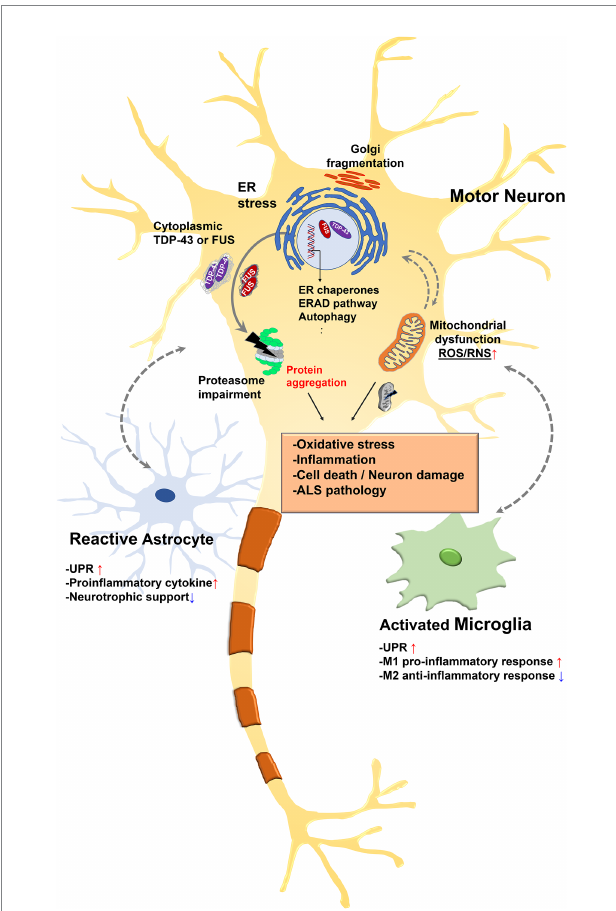
FIGURE 2 Relationship between endoplasmic reticulum (ER) stress and amyotrophic lateral sclerosis (ALS)-associated pathology. Misfolded proteins accumulate in the ER lumen and this accumulation contributes to ER stress. ER stress triggers the UPR to restore protein homeostasis. However, chronic stress leads to a cascade of intracellular death and inflammatory signal. Some nuclear ALS disease proteins such as TAR DNA-binding protein 43 (TDP-43) or fused in sarcoma (FUS) are depleted in the nucleus and accumulate in the cytoplasm in pathologic condition. Pathologic TDP-43 or FUS are existed as hyperphosphorylated and ubiquitinated form. Persistent activation of the stress response leads to ER dysfunction and ubiquitin proteasome system (UPS) impairment, leading to reactive oxygen species (ROS) and RNS release in mitochondria. This eventually leads to insoluble cytoplasmic aggregation and impairment of mitochondrial and ER function. Furthermore, UPR-related genes are upregulated in astrocytes and microglia along with inflammatory genes. Specifically, UPR activation reduces the ability of glia to support synapse and is associated with neuronal cell death. In addition, glia could transmit ER stress to neurons, which in turn may exacerbate ER stress mediated neuronal